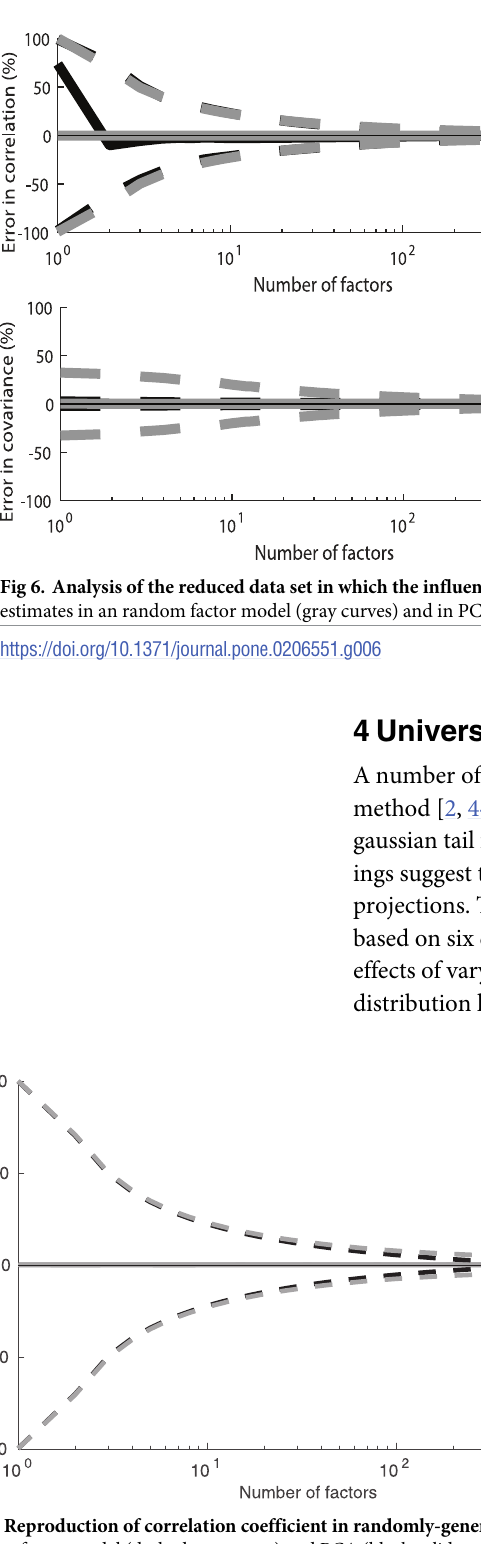
PLOS ONE | https://doi.org/10.1371/journal.pone.0206551 December21,